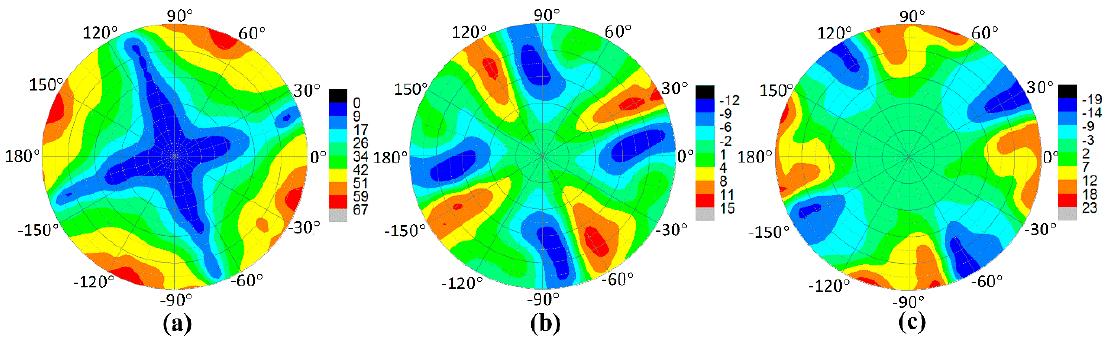
Figure 4. Lattice rotation angles recorded on the surfaces of the initial (001) aluminum single crystal after N = 1/12 turn of HPT deformation: ( a ) around R axis, ( b ) around (cid:2016) axis and ( c ) around Z